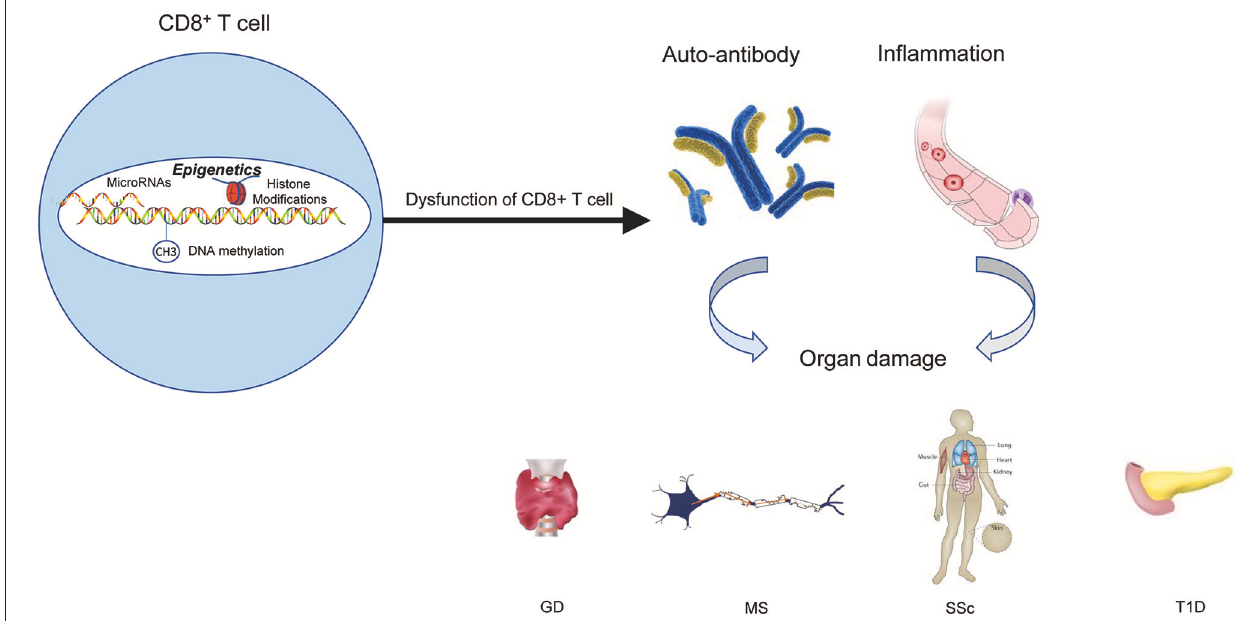
FIGURE 4 | The epigenetic role of CD8 + T cells in autoimmune diseases. Epigenetic mechanisms participate in CD8 + T cells’ activation, differentiation, and development, and finally lead to the dysfunction of CD8 + T cells. The results of dysfunction of CD8 + T cells can initiate abnormal CD8 + T-cell responses, thus triggering the production of autoantibodies and inflammation that lead to autoimmune diseases.